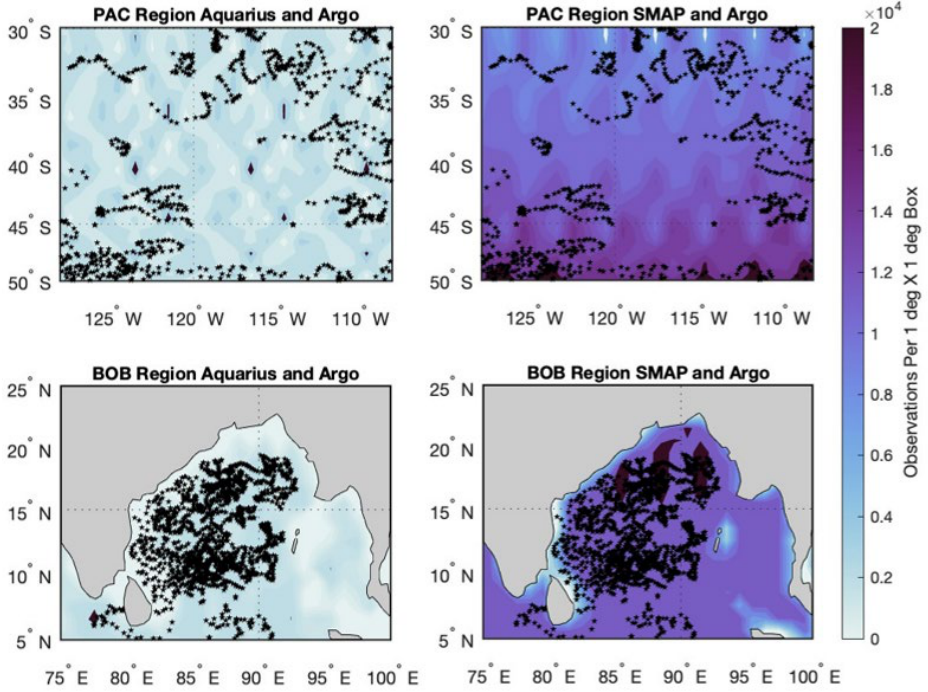
Figure 13. Colors with scale at right: Coverage of the Aquarius ( left column) and SMAP satellites ( right column). Black symbols: Argo float observations for the entire year of simulated data in the PAC ( top row) and BOB ( bottom row) region.